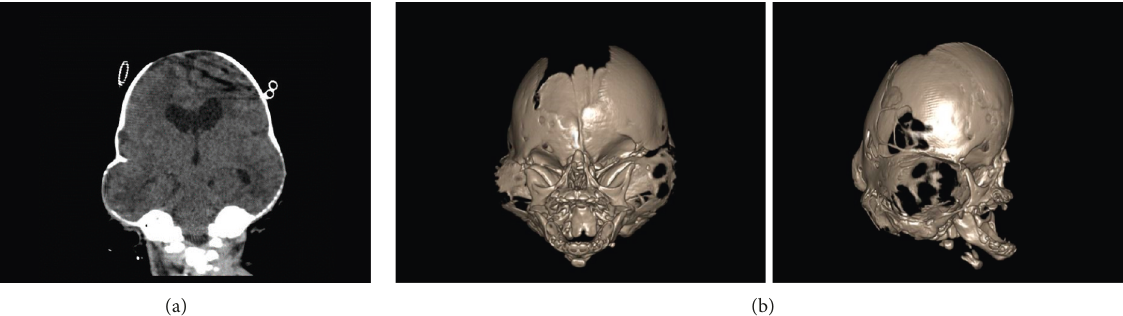
Figure 3: (a) CTscan of the head showing marked cloverleaf deformity with lateral ventricle dilatation. (b) Three-dimensional craniofacial reconstruct computed tomography of the skull (AP and lateral) demonstrating early closure and overlapping of all the cranial sutures with cloverleaf